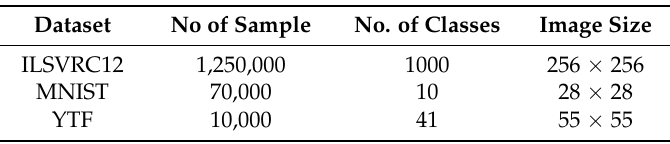
Table 1. Description of